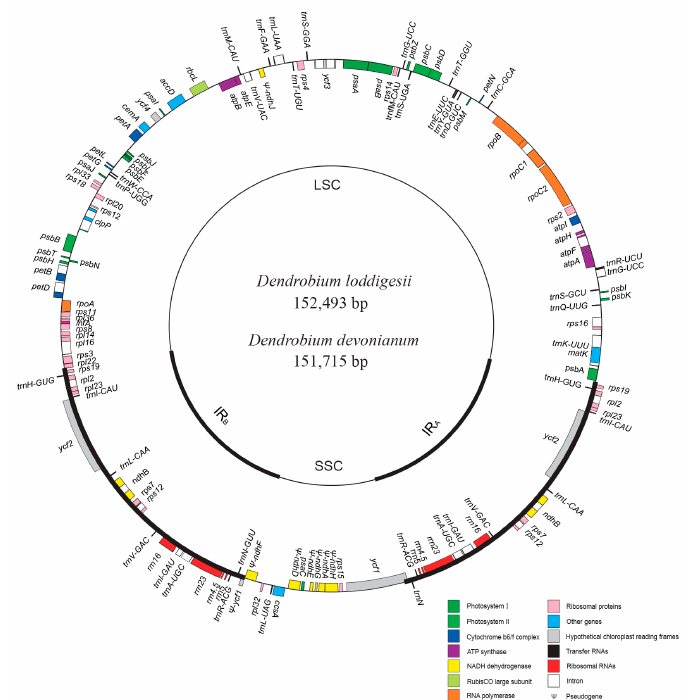
Figure 1. Genome map of two newly sequenced Dendrobium plastomes. Only the plastome of D. loddigesii is shown because it has an identical structure with D. devonianum . Genes outside and inside the circle are transcribed clockwise and counterclockwise, respectively. LSC: large single-copy; SSC: small single-copy; IR A and IR B : two identical inverted repeats.